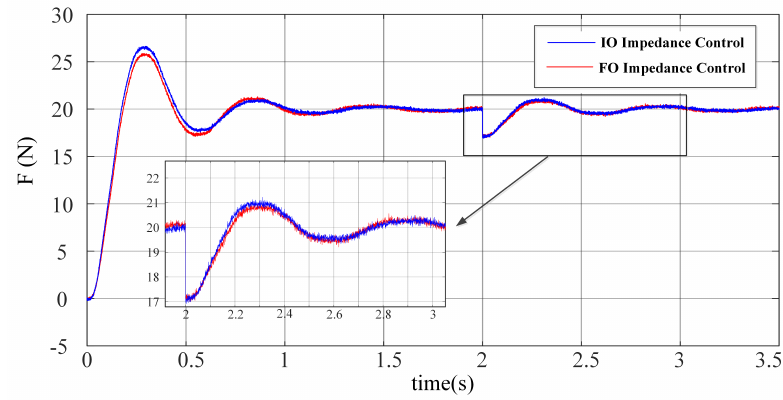
Figure 14. Experimental comparison of FO/IO-impedance controller.